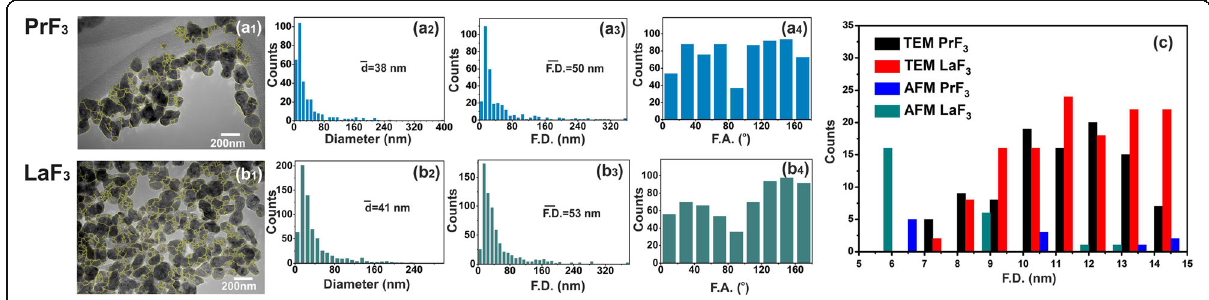
Fig. 3 TEM digital ( x , y ) size histograms of RE-NPs. ( a1, b1 ) TEM images of RE-NPs. Yellow lines indicated 2D boundaries between RE-NPs. ( a2, b2 ) ( x , y ) size histograms of mean equal circle area diameter ð d Þ of RE-NPs. ( a3, b3 ) ( x , y ) size histograms of Feret area diameter ð F : D : Þ of RE-NPs. ( a4, b4 ) Feret angle (F.A.) histograms relative to the x -axis with preferential directions at ±(44 – 60°). ( c ) Size histogram of Feret diameter of small and tiny size RE-NPs extracted from both AFM and TEM images for 4 μ m 2 areas